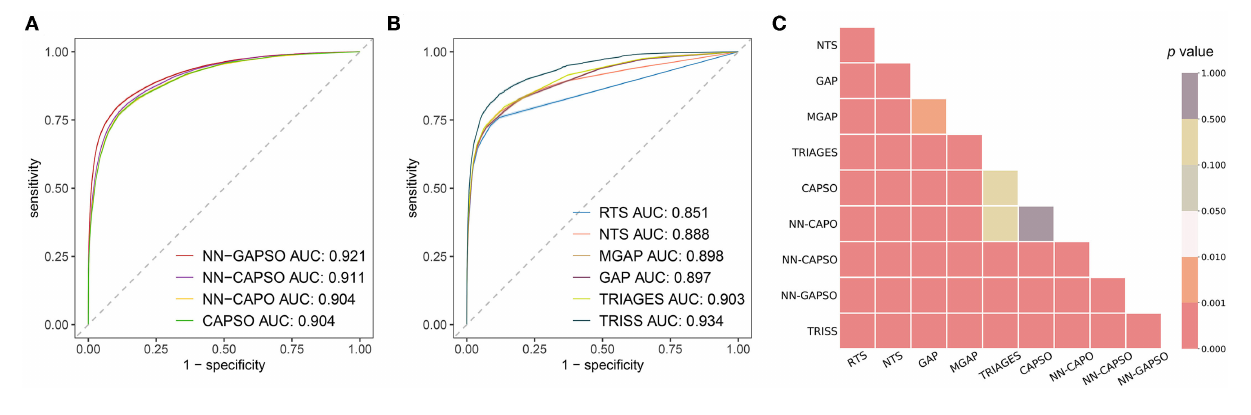
FIGURE 2 | The discrimination of models/scores in the validation cohort. (A) Receiver operating characteristic curves for newly developed models; (B) receiver operating characteristic curves for trauma scores; (C) p values for a two-by-two comparison between different models and scores. NN , Neural network; GAPSO , Glasgow Coma Scale, Age, Pulse Rate, Systolic Blood Pressure, and Peripheral Oxygen saturation; CAPSO , the Ability to Follow Commands, Age, Pulse Rate, Systolic Blood Pressure, and Peripheral Oxygen saturation; CAPO , the Ability to Follow Commands, Age, Pulse Rate, and Peripheral Oxygen saturation; RTS , Revised Trauma Score; NTS , New Trauma Score; MGAP , Mechanism, Glasgow Coma Scale, Age, and Arterial Pressure; GAP , Glasgow Coma Scale, Age, and Systolic Blood Pressure score; TRIAGES , Trauma Rating Index in Age, Glasgow Coma Scale, Respiratory rate and Systolic blood pressure; TRISS , Trauma and Injury Severity